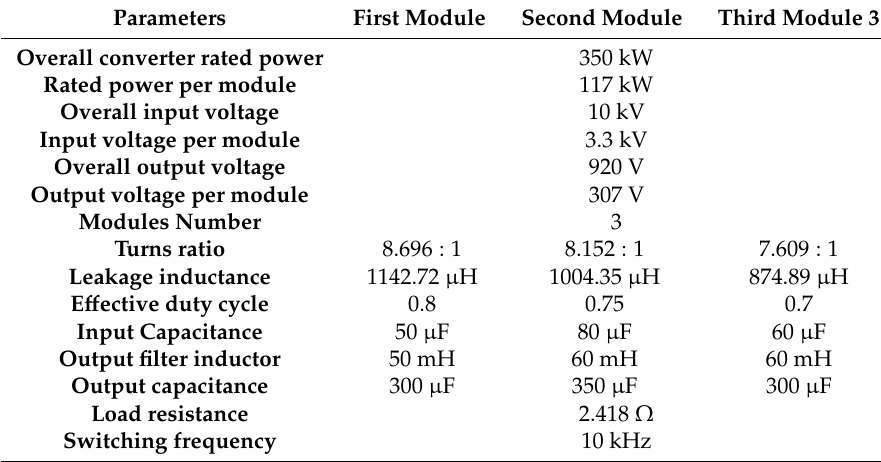
Table 8. Input-Series Output-Series (ISOS) converter parameters.